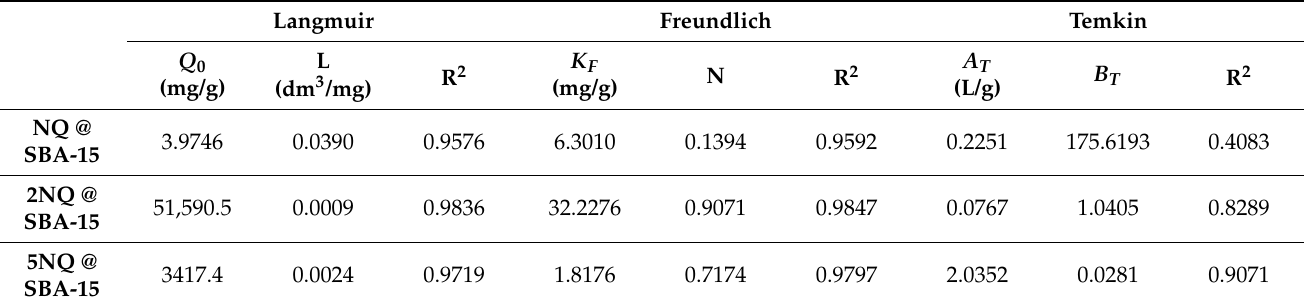
Table 2. Langmuir, Freundlich, and Temkin isotherm parameters obtained by non-linear fittings